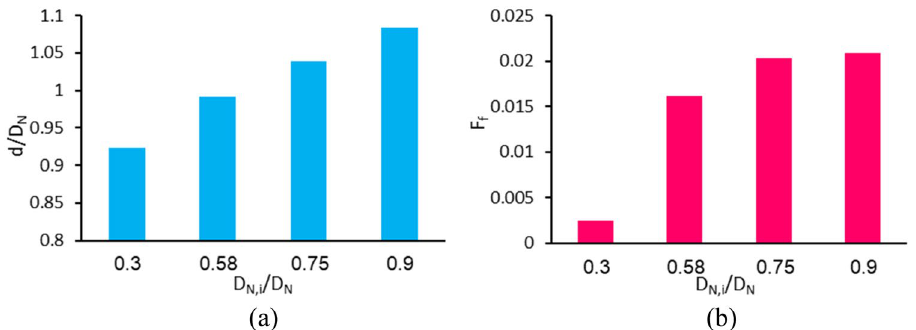
Figure 14. Magnetic field strength contours and magnetic lines for ( a ) D core D 17.75 . As the ferrite core diameter increases, the magnetic field around the nozzle tip is more constant t core D N = uniform, and the magnetic field lines become parallel.